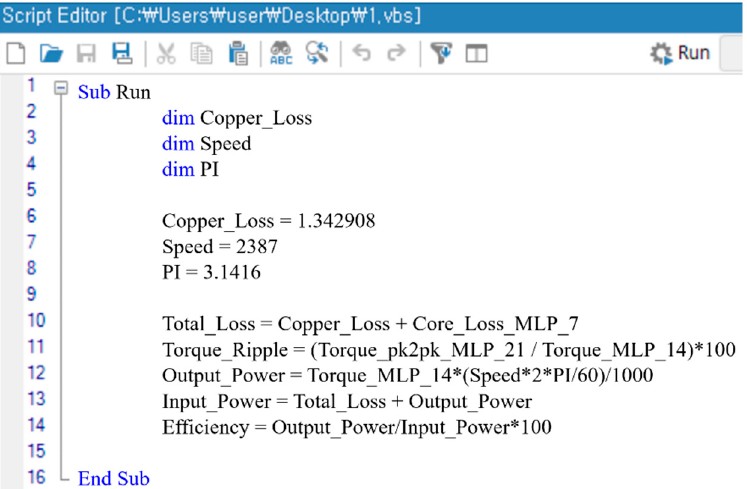
Figure 8. VBScript used to calculate torque ripple and efficiency using metamodels.